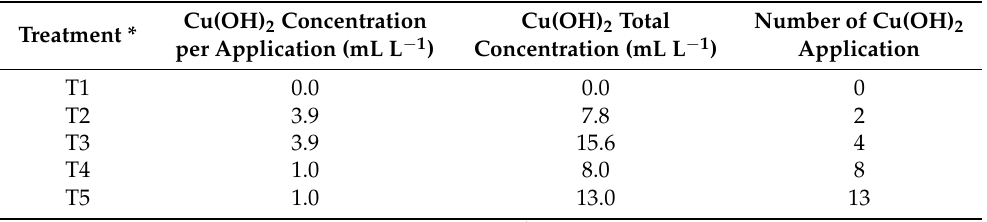
Table 1. Discriminated treatments in fruits of atemoya ( Annona × atemoya Mabb.) cv. Thompson. Botucatu, S ã o Paulo, Brazil,